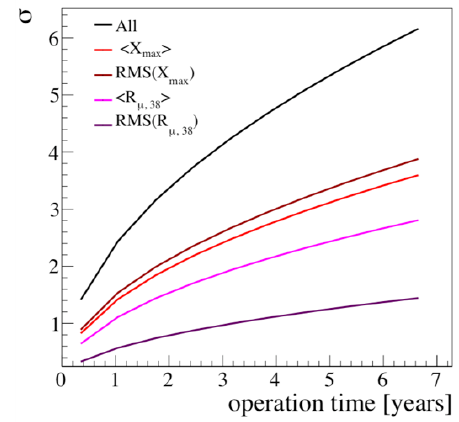
Figure 8. Significance of distinguishing Scenarios 1p and 1 (with and without at least 10% protons respectively) as a function of the operation time of